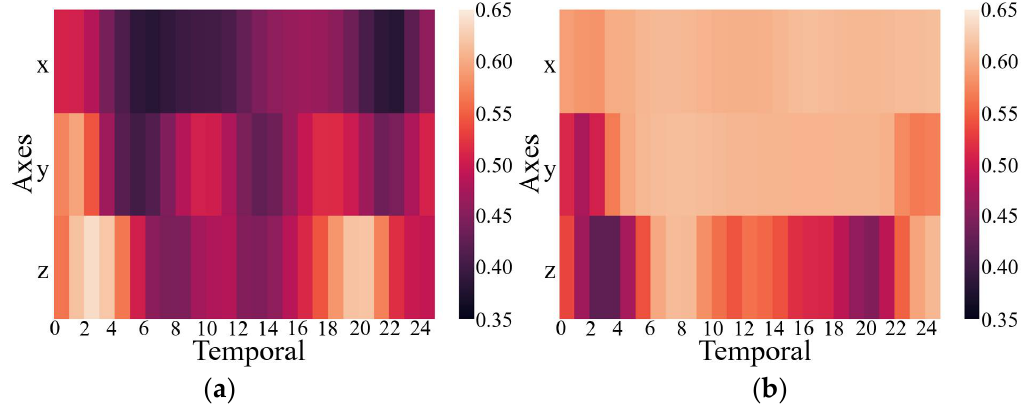
Figure 4. Attention maps for features extracted from the triaxial accelerometer ( a ) and gyroscope ( b ) data.